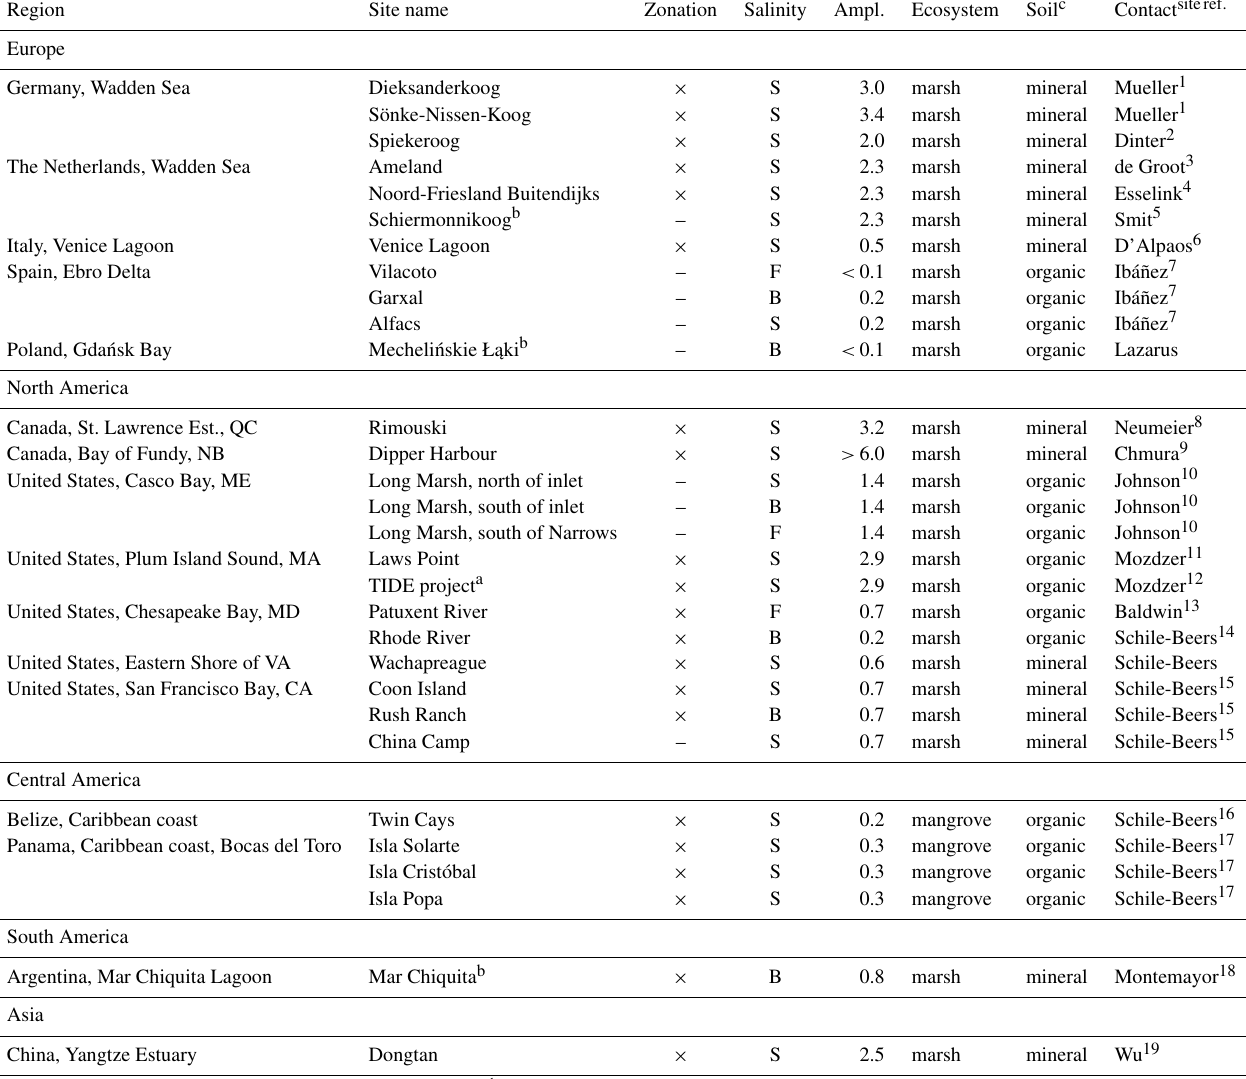
Table 1. Overview of study regions, site names, and site properties. Sites in which tea bags were deployed in zones of different elevation and flooding frequency are marked ( × ). Different salinity classes are indicated as “S” (salt water), “B” (brackish water), and “F” (fresh water). Tidal amplitude (Ampl.) is given in